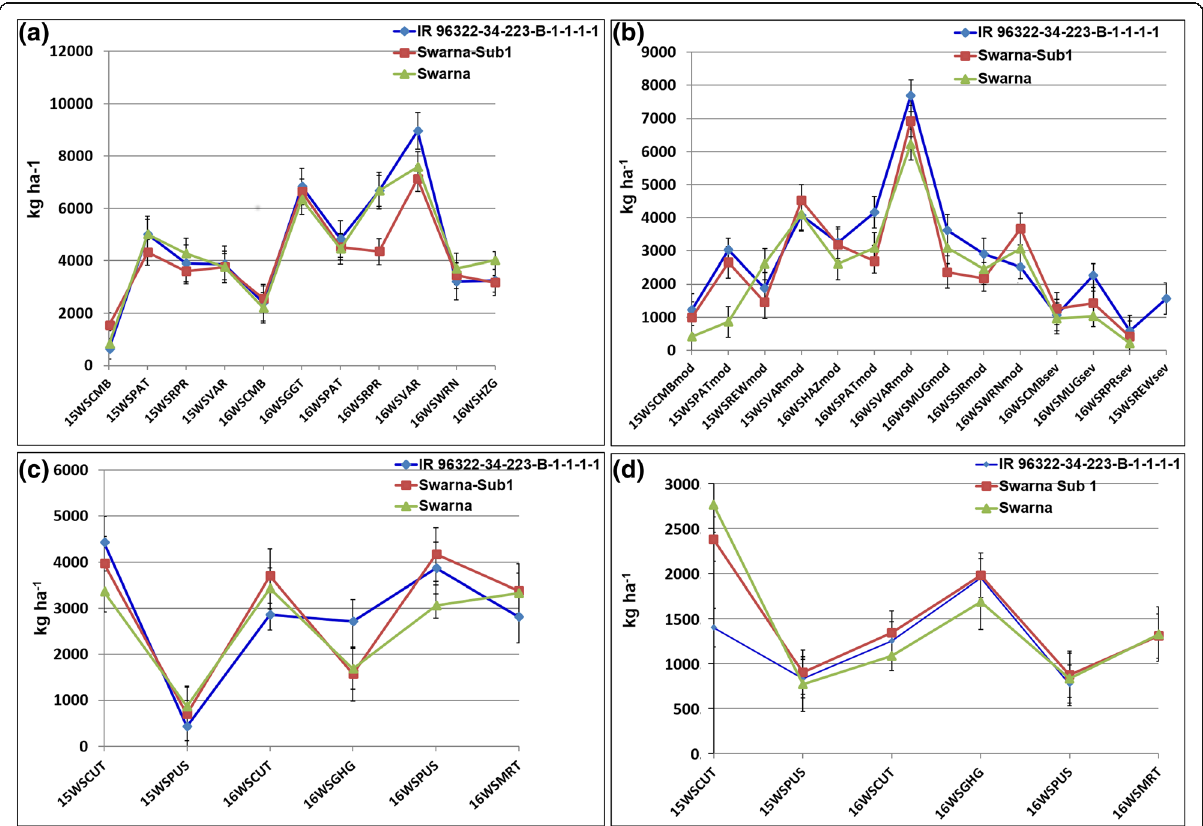
Fig. 3 The grain yield performance of IR 96322-34-223-B-1-1-1-1 in comparison with Swarna-Sub1 and Swarna ( a ) under NS {control for RS}; b under RS; c under NS {control for Submergence}; d under Submergence in 2015WS and 2016WS in different locations under AICRIP trials in India. CMB: Coimbatore, CUT: Cuttack, GGT: Ghaghraghat, HZG: Hazaribag, MUG: Mugad, MRT: Maruteru, PAT: Patna, PUS: Pusa, RPR: Raipur, REW: Rewa, SIR: Sirsi, VAR: Varanasi, WRN: Warangal, DS: dry season, WS: wet season, NS – non-stress, RS: reproductive stage drought stress, mod: moderate drought stress, sev: severe drought stress